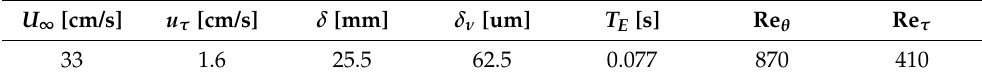
Figure 2. Schematic of dynamic roughness slot (at x = 0) and the compliant wall insert ( left ) and a finished gelatin sample ( right ). Note the sample pictured was dyed white for a DIC test. The gelatin used in the experiments was translucent. Table 1. Mean properties of the canonical flow, acquired at 63 cm downstream of the leading edge: turnover time T E = δ / U ∞ , Reynolds numbers based on momentum thickness, Re θ , and friction Reynolds number, Re τ